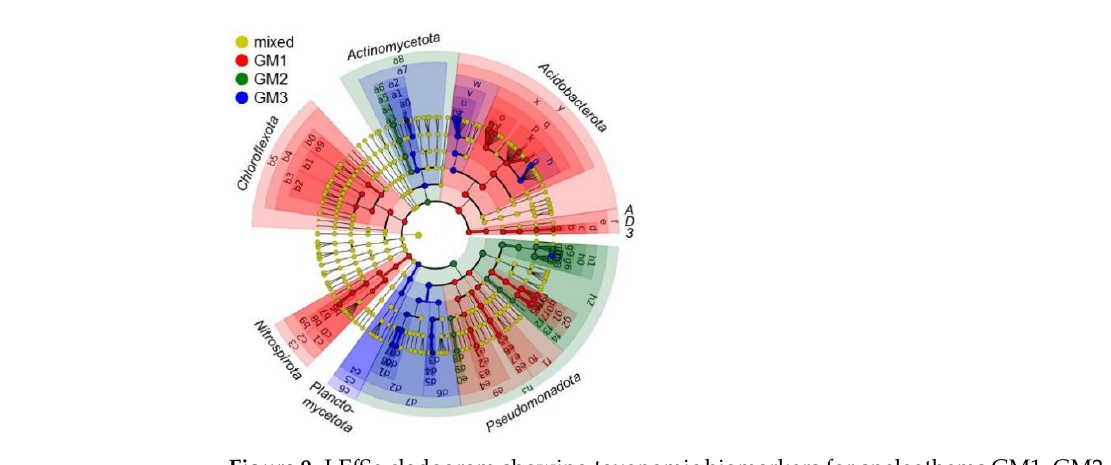
Figure 9. LEfSe cladogram showing taxonomic biomarkers for speleothems GM1, GM2, and GM3. The innermost node corresponds to the Bacteria domain, followed by the concentrically arranged nodes of class, order, family, genus, and species. Red, green, and blue nodes/shades indicate taxa that are significantly higher in relative abundance. The diameter of each node is proportional to the abundance of the taxon. Codes in the cladogram with corresponding taxonomic ranks/names are listed in supplementary Figure S11. Table 4. Taxonomic biomarkers having LDA scores >5 and their corresponding codes in Figure 9 and Figure S12. All biomarkers with LDA scores >4 are shown in Supplementary Table